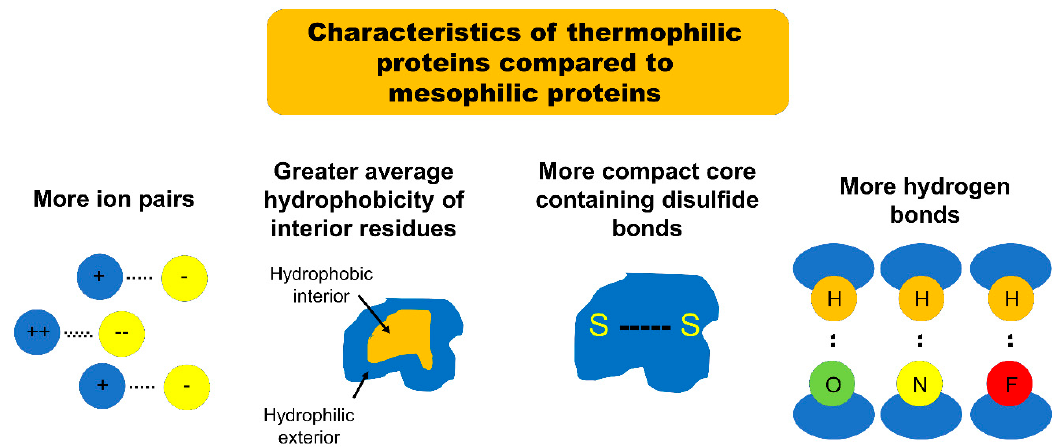
Figure 1. A schematic of characteristics of thermophilic proteins when compared to mesophilic